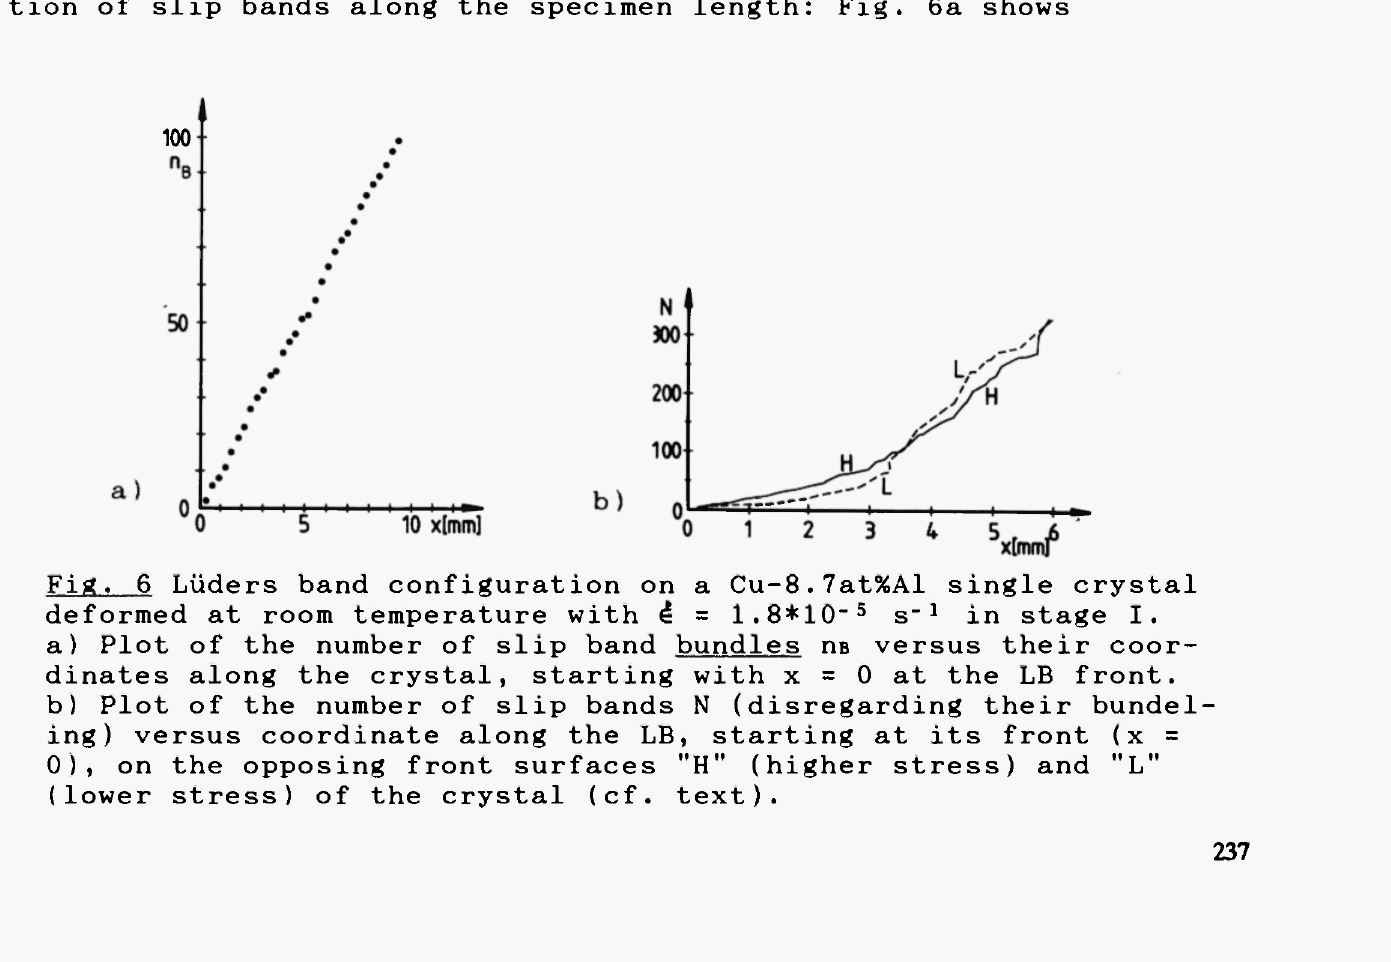
Fig. 6 Lüders band configuration on a Cu-8.7at%Al single